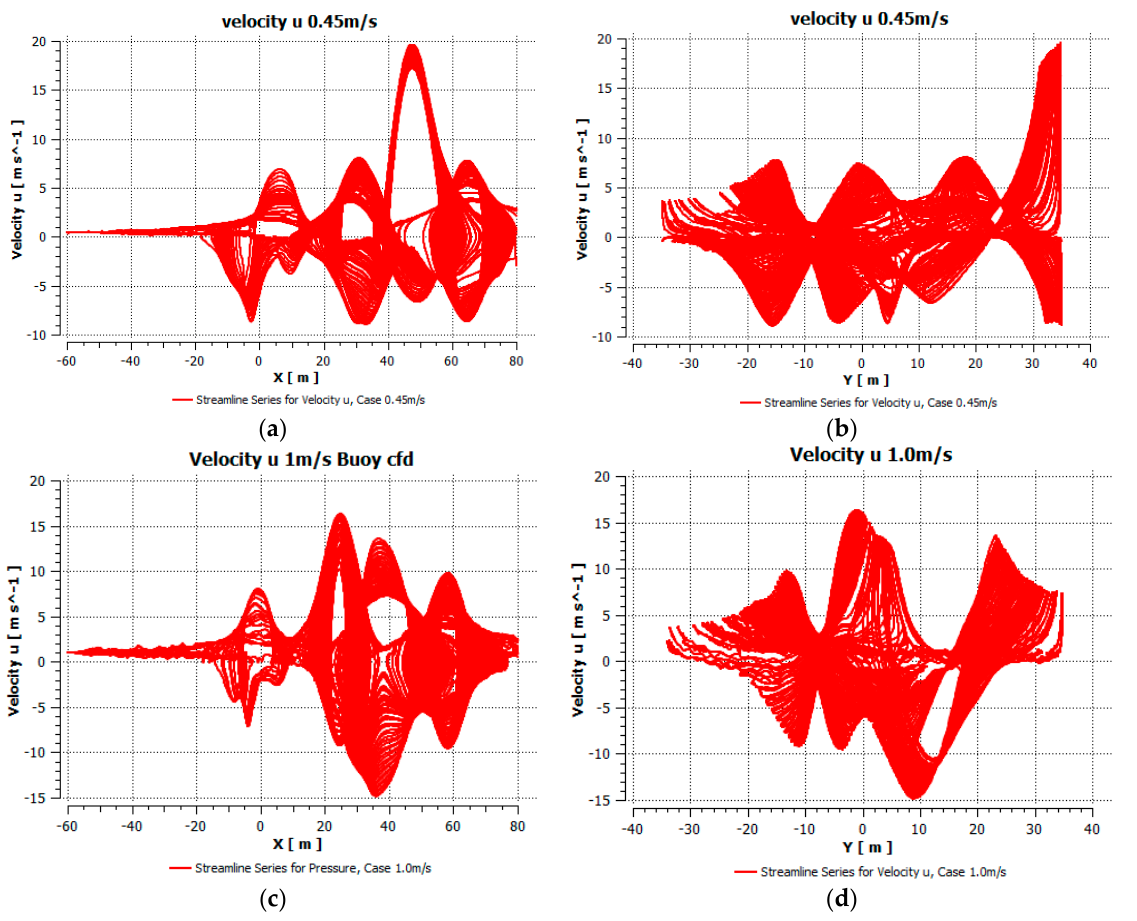
Figure 11. Vortex effect on the free-floating buoy showing flowlines and fluid-structure interaction.